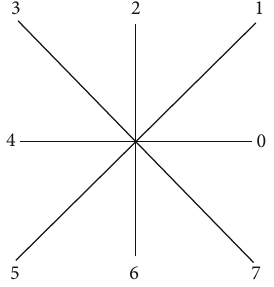
Figure 3: Values assigned to each neighboring pixel in the signi fi ed direction in an 8-connected grid.